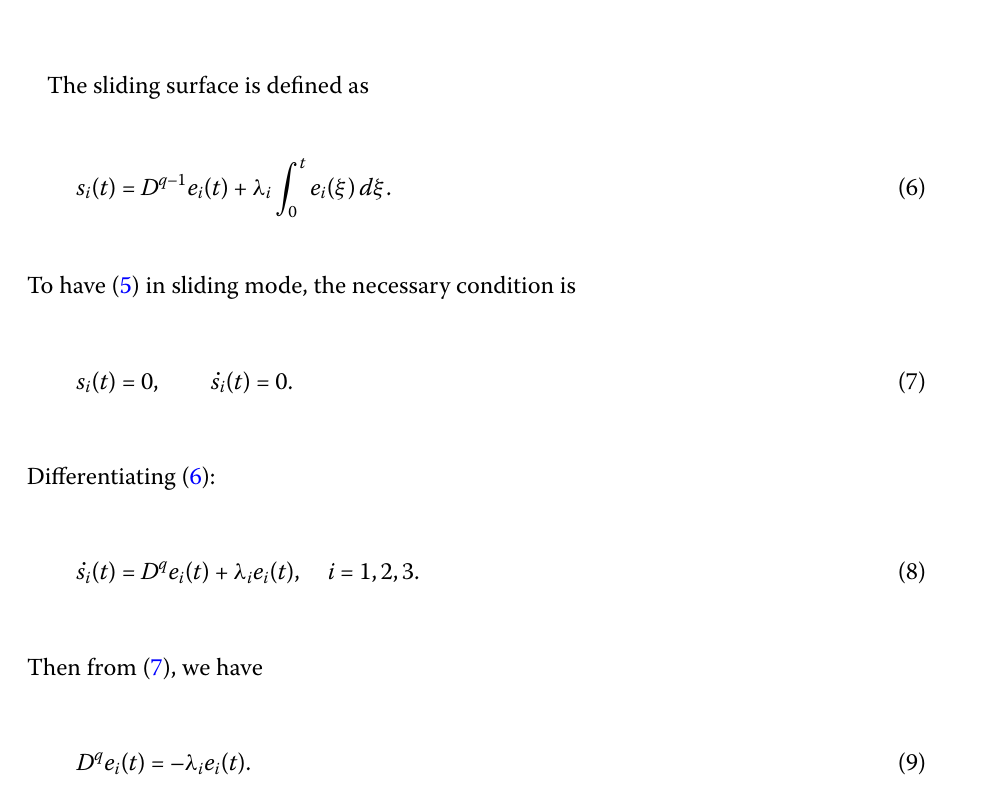
The sliding surface is defined